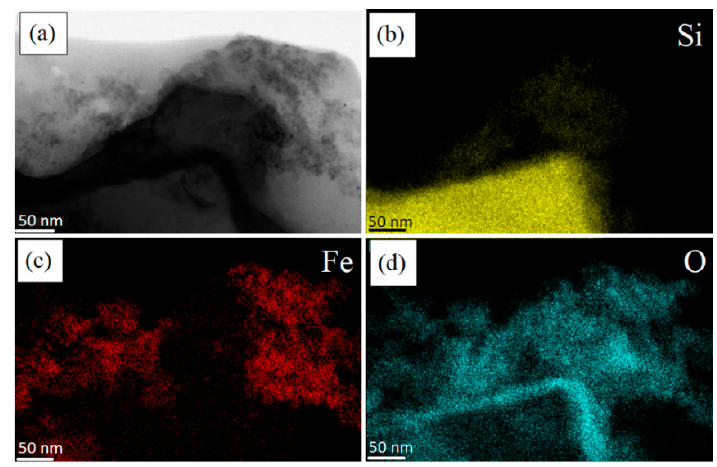
Figure 6. STEM (BF) images of: ( a ) a pSi microparticle after SPIONs decoration at 50 nm scale; elemental mapping of: ( b ) Si; ( c ) Fe; ( d ) O.